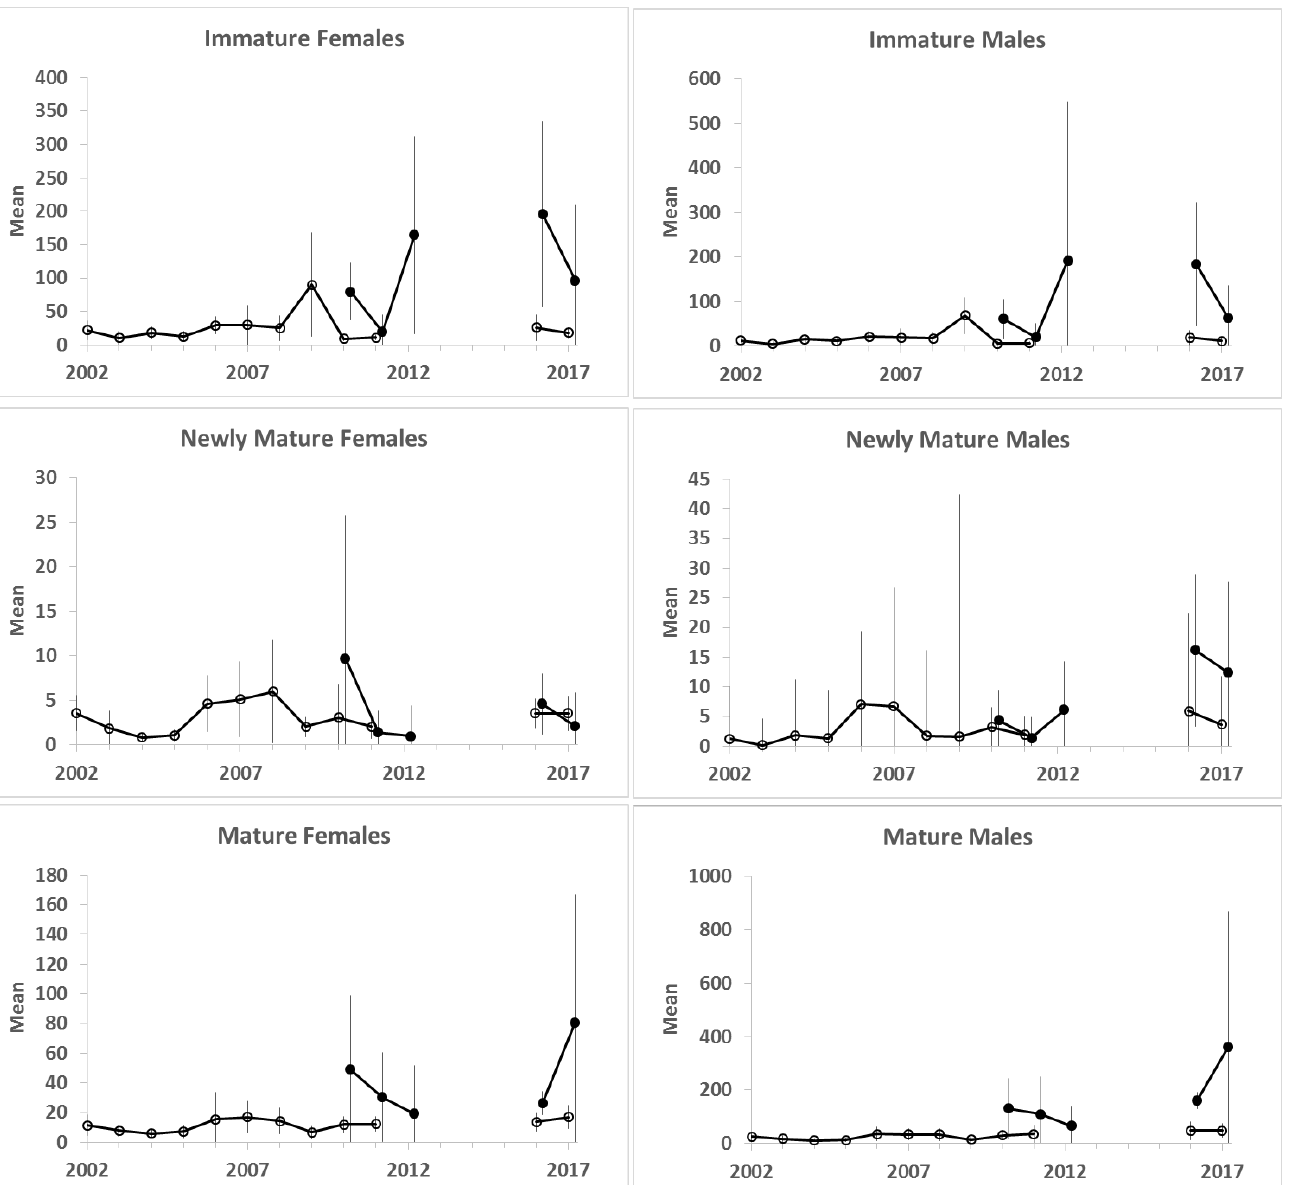
Figure 60. Delta distribution model mean catches per tow of horseshoe crabs in the lower Delaware Bay survey by demographic group with coastal Delaware Bay area survey means for comparion. Vertical lines indicate 95% confidence limits. Solid symbols indicate the lower Delaware Bay survey. Open symbols indicate the coastal Delaware Bay area survey. Note differences in y-axis